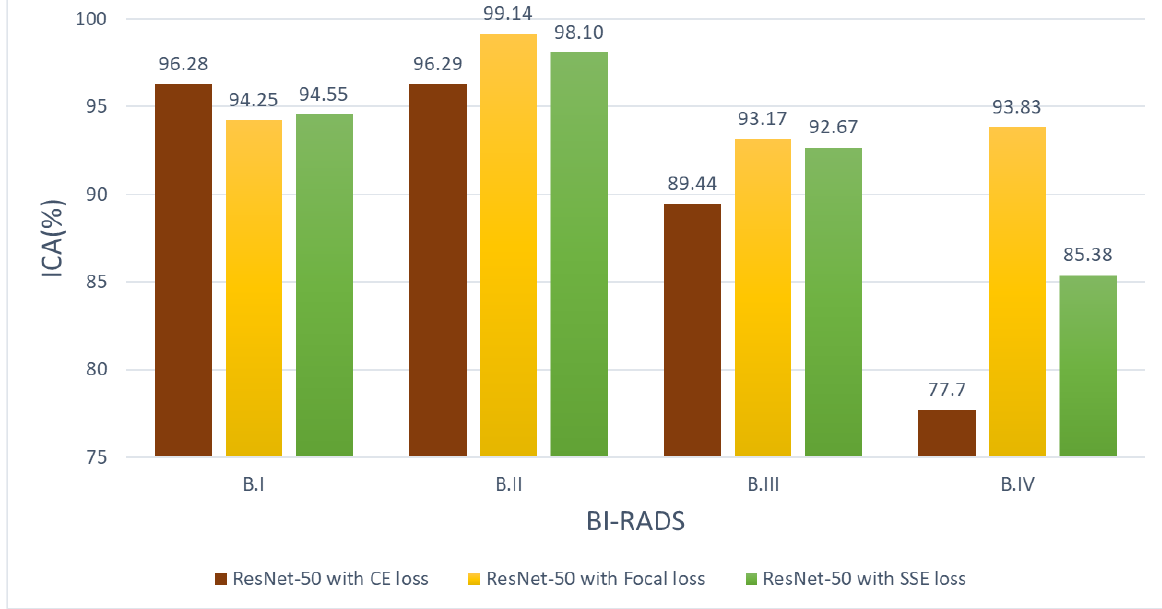
Figure 7. The effect of different loss functions of the DDSM test individual classification accuracy. Table 6. The effect of different loss functions of the DDSM test.